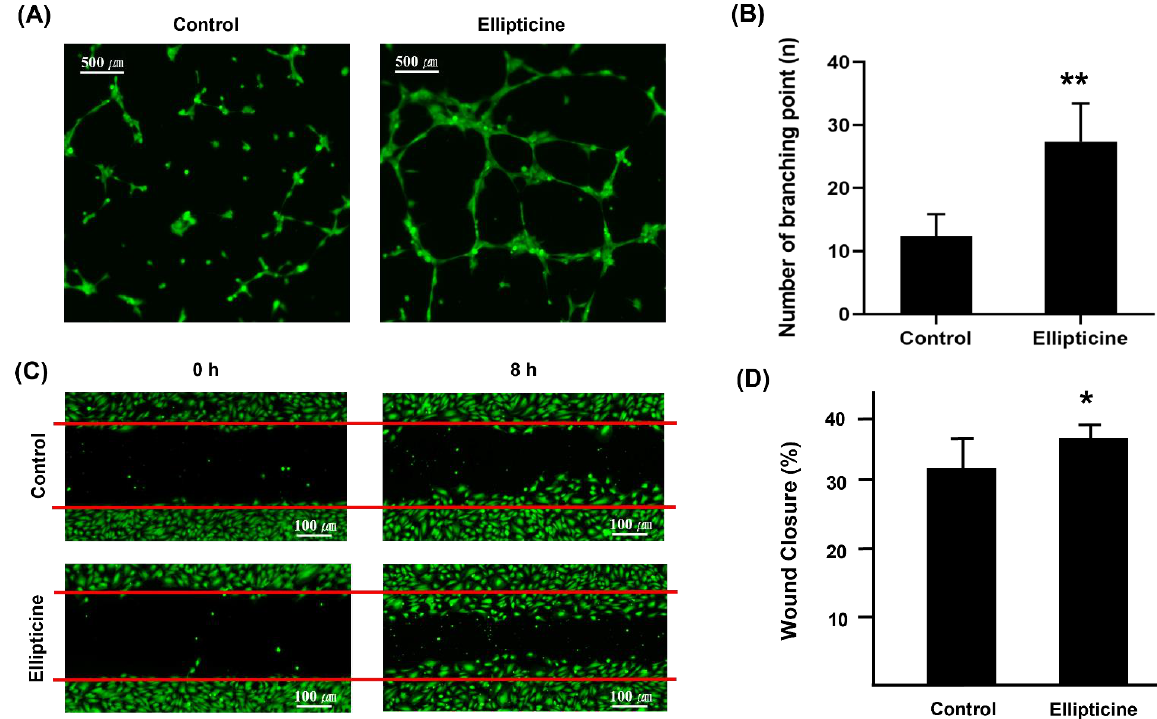
Figure 5. In vitro angiogenesis assay using HUVECs. HUVECs tube-forming assay ( A ) measured by the number of junctions. DMSO was used as a negative control (40 × magnification, scale bar = 500 μm). It reveals reassembly of endothelial cells (green dot) and formation of new cell-cell contacts, vessel lumina, and cell network formation (green line) in ellipticine-treated cells were significantly enhanced as compared with control. Graph ( B ) shows significant activation of endothelial tube formation by ellipticine at 156.25 nM. Confluently cultured endothelial cells were wounded using a sterile tip and treated without or with 156.25 nM ellipticine for 8 h ( C ) (40 × magnification, scale bar = 100 μm). There is a significant difference in the amount and velocity of vascular endothelial cells (green dot) migrating from both sides to fill the gap in the wound (red line). The wound closure levels are shown ( D ). * p < 0.05, ** p < 0.01.